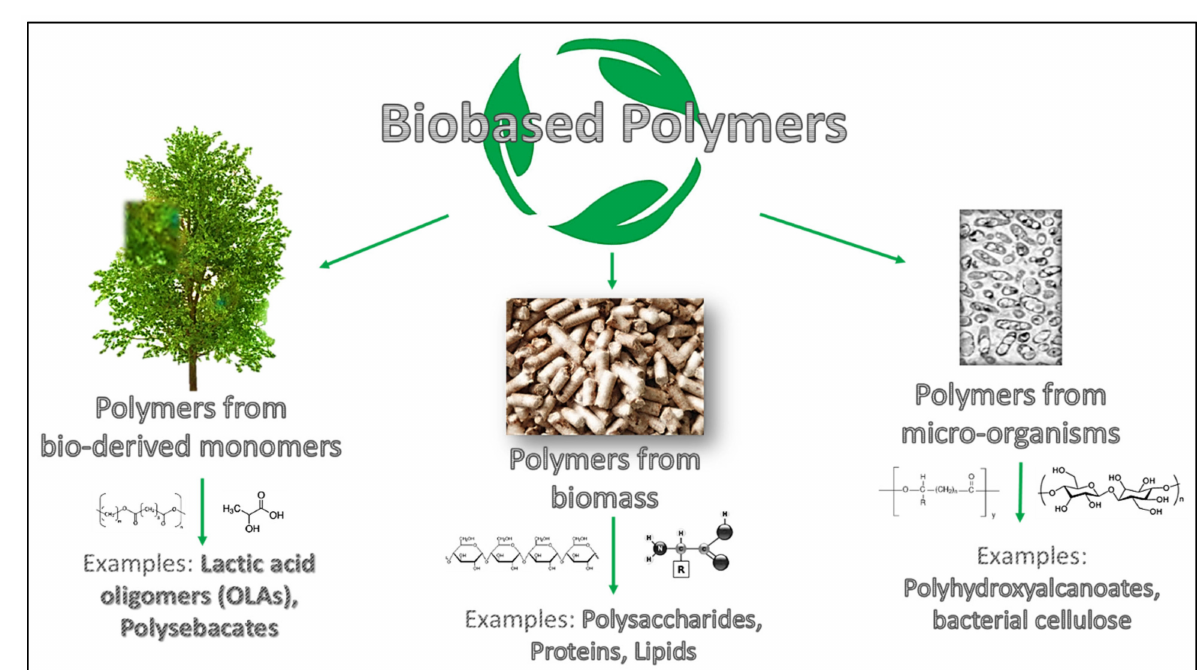
Figure 1. Schematic overview of bio-based polymers’